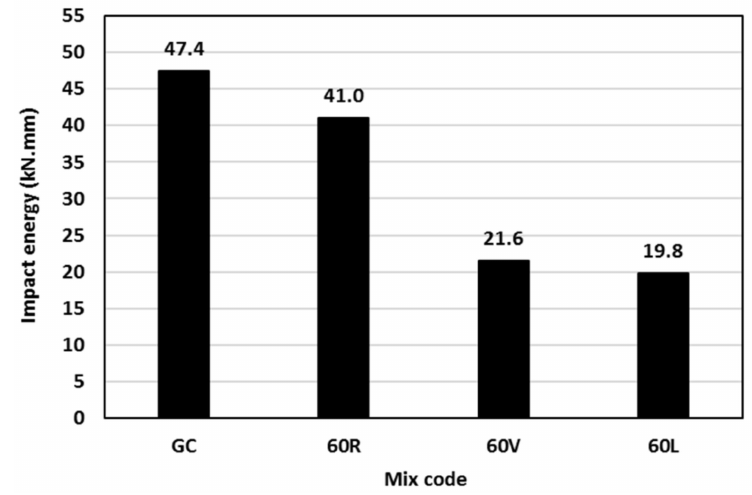
Figure 11. Impact resistance of geopolymer concrete mixes.